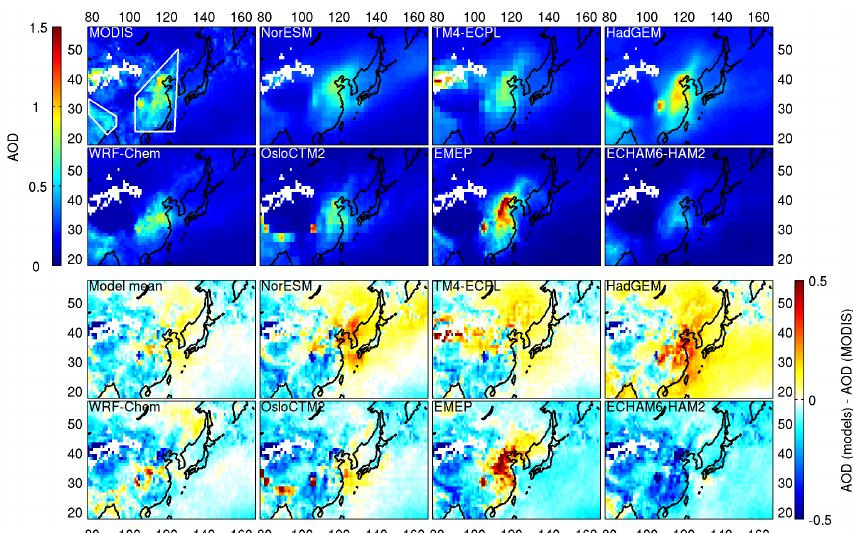
Figure 8. Top panels: mean AODs observed by MODIS and simulated by the ECLIPSE models for August and September 2008. Bottom panels: absolute differences between the simulated and the MODIS AODs (models names are given in each relevant panel). White polygons mark out the two regions discussed in the